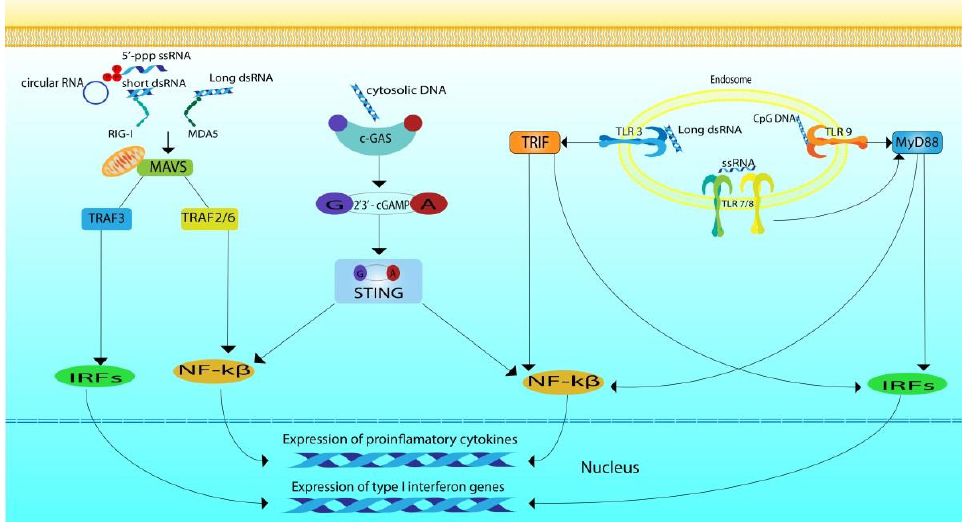
Figure 1. Nucleic acid recognition (drowning was created using Adobe Illustrator (Adobe Inc.,